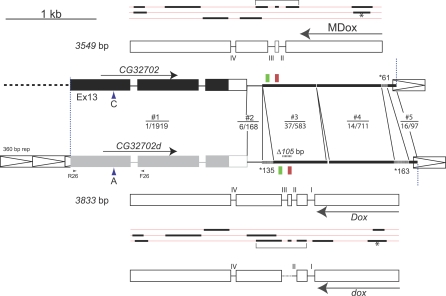
Molecular Structure of Dox and MDox
Both Dox and MDox have transcripts in the opposite direction of CG32702d or CG32702, respectively. The genomic sequences of Tp3833 (Dox) and Tp3549 (MDox) are largely homologous except for one indel of 135 bp (*135) and another short sequence (*61 in MDox versus *163 in Dox). The 360-bp repetitive sequence may have been involved in the transposition event of Tp3833. Five homologous segments of sequences are recognized. The nucleotide divergence is shown for each of them (#1–#5) expressed as nucleotide difference over segment length. Segment #1 corresponds to the last exons of CG32702 and it has only one nucleotide substitution (A versus C in Ex 13) between these two paralogs. R26 and F26 are the two PCR primers used to amplify genomic DNA and cDNA in this region (see Figure S4). The transcripts of Dox and MDox were determined by RT-PCR, 5′- and 3′-RACE with primers that can distinguish between these two genes. The intron–exon boundaries of these two genes are largely the same between Dox and Mdox, so they are annotated together. However, the 91-bp intron I of Dox has never been found from MDox. Several alternative splicing forms including earlier termination have been found. In some RT-PCR products, introns III and IV of MDox are not spliced out. Other splice forms may yet be uncovered. The 105-bp deletion (dashed line) in dox causes the loss of exon III in the otherwise identical transcripts as compared to Dox. Identical tandem repeats of a 42-bp element (green and red rectangles) are present in both Dox and MDox transcripts. It is unclear which ORF, if any, is actually translated in each transcript. All potential ORFs larger than 100 bp are shown for all three reading frames (thick black lines on thin red lines). Two ORFs of 157 and 107 aa across the exon III region in the Dox and MDox transcripts, respectively, are marked with brackets and are the strongest candidate for translation (see Text S2). The best ORF predicted by GENSCAN are marked with an asterisk (http://genes.mit.edu/GENSCAN.html).